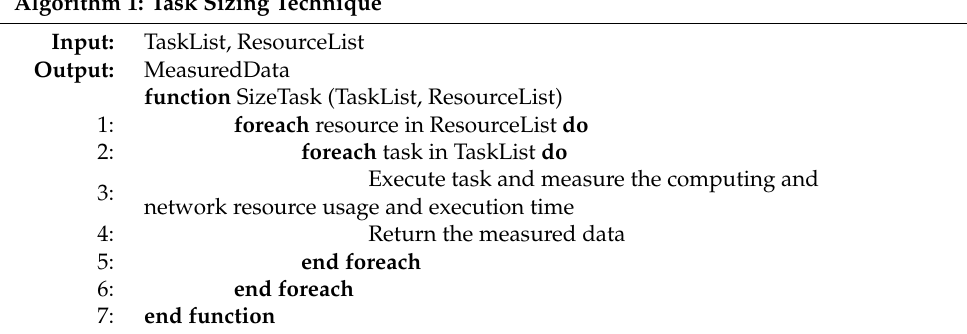
Algorithm 1: Task Sizing